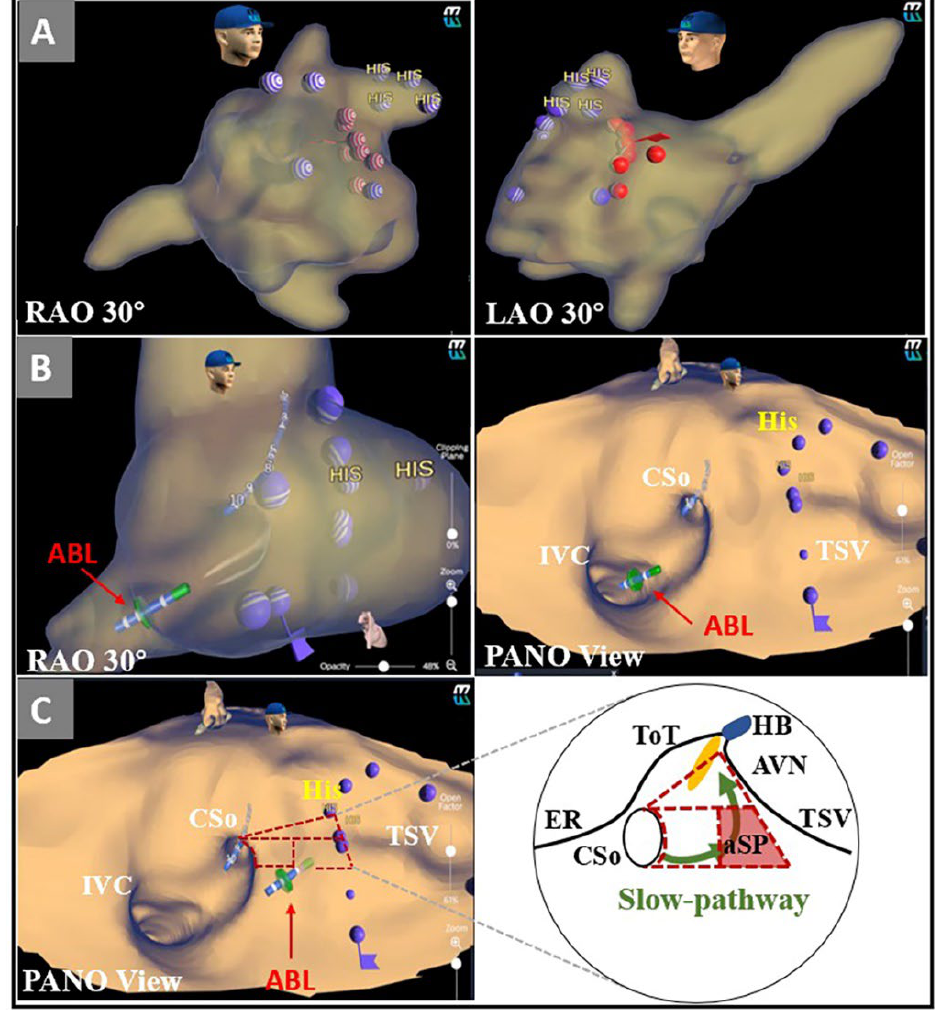
Figure 3. Stepwise approach to ablation of the aSP region under the guidance of PANO View. ( A ) Target distributions in RAO and LAO views; ( B ) The ablation catheter was advanced to the para-SP region under the guidance of PANO View; ( C ) The ablation catheter was targeted to the aSP region and began ablation. ABL = ablation catheter; AVN = atrioventricular node; CSo = coronary sinus ostium; ER = Eustachian ridge; HB = His bundle; IVC = inferior vena cava; LAO = left anterior oblique; PANO View = Panoramic View; RAO = right anterior oblique; ToT = tendon of Todaro; TSV = tricuspid septal valve.